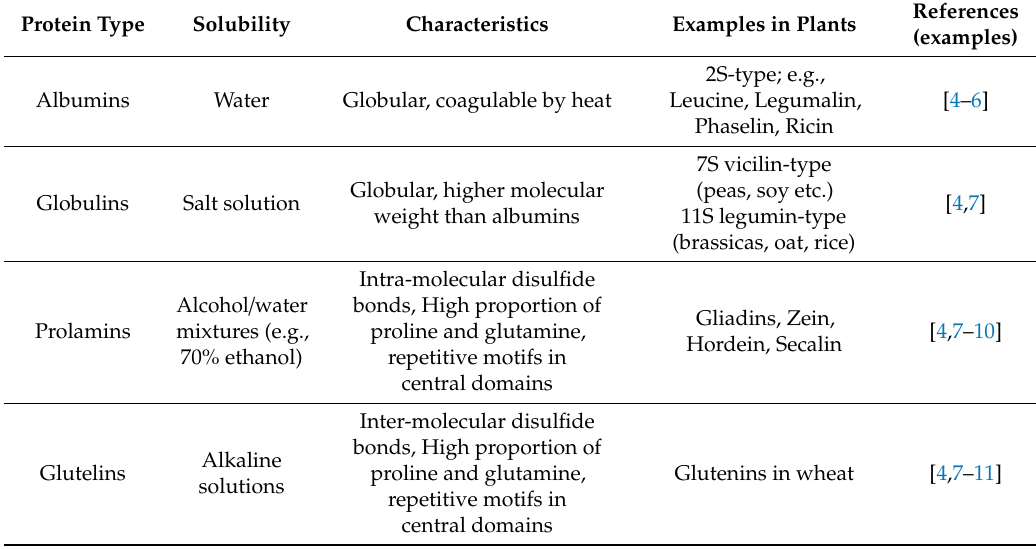
Table 1. Types, characteristics (based on Osborne fractionation [3,4]), and presence of plant proteins. Protein Type Solubility